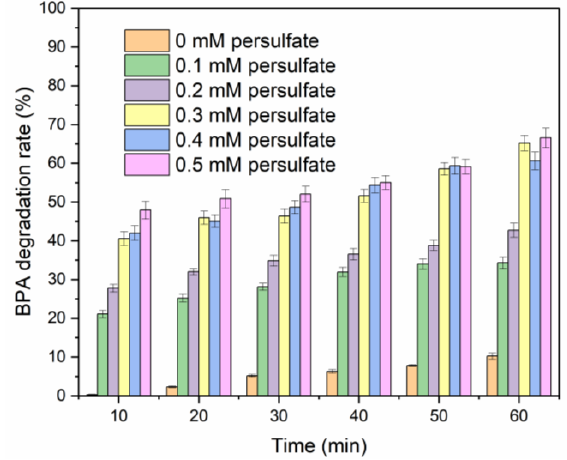
Figure 2. The effect of PS concentration on BPA degradation. [BPA] = 5 mg/L, [magnetite] = 0.1 g/L, T = 20 °C, pH = 7.0.